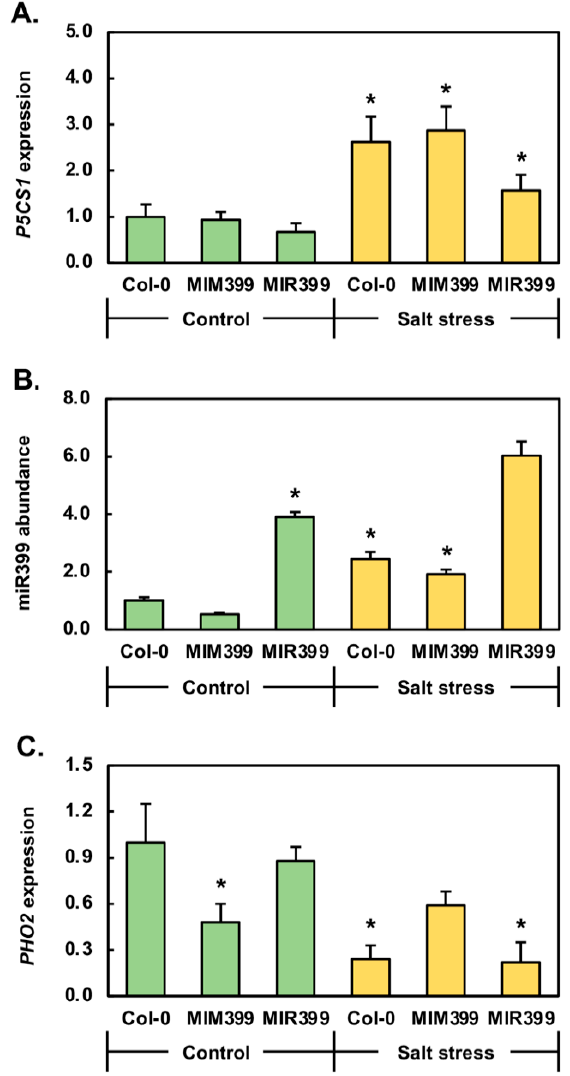
Figure 3. RT-qPCR analysis of P5CS1 , miR399 and PHO2 transcript abundance in 15-day-old control and salt-stressed Col-0, MIM399 and MIR399 seedlings. Quantification of P5CS1 ( A ), miR399 ( B ) and PHO2 ( C ) expression via RT-qPCR assessment of 15-day-old control and salt-stressed Col-0, MIM399 and MIR399 seedlings. Error bars represent the standard deviation of four biological replicates and the presence of an asterisk above a column represents a statistically significant difference in the abundance of an assessed transcript between the Col-0, MIM399 and MIR399 plant lines ( p -value: * <